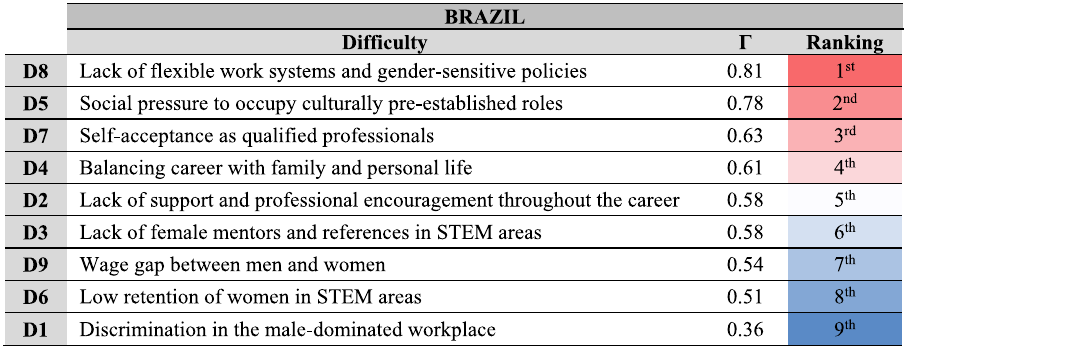
Table 7 Ranking of difficulties in